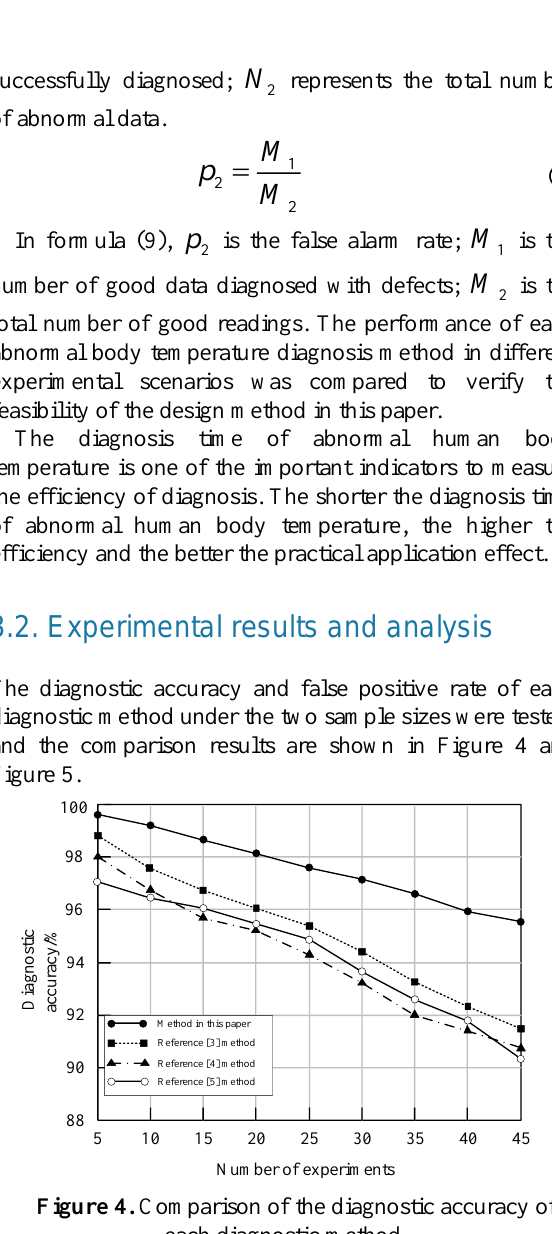
Table 1. Diagnosis time of abnormal